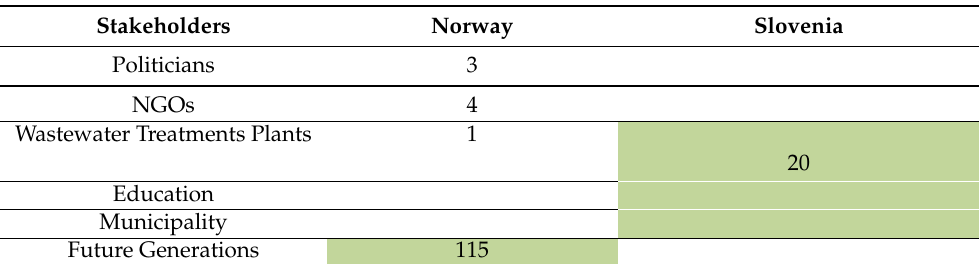
The field marked in green represents the stakeholder sectors where workshops were held. Table 1. Overview over the number of participants from each sector on plastic pollution perceptions. Green marks the workshops, whereas the others are in-depth